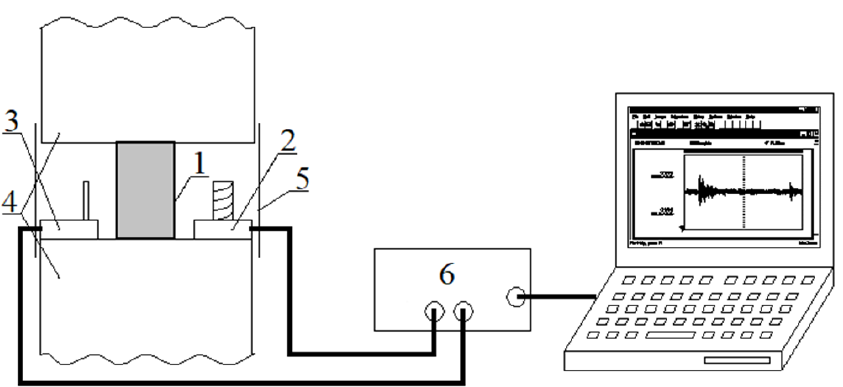
Figure 3. Measuring system for recording electromagnetic fields from rock samples subjected to destructive loading 1—test sample, 2—magnetic field receiver, 3—electric field receiver, 4—hydraulic press, 5—electromagnetic screen, 6—measuring card.